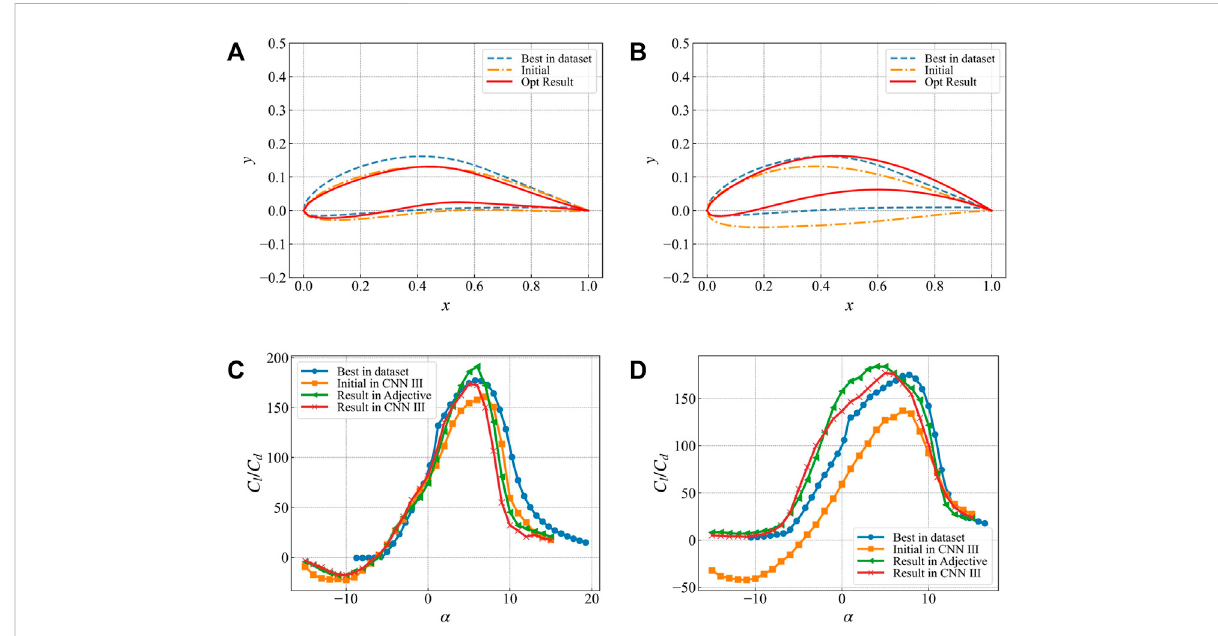
FIGURE 13 Comparisonofoptimizationresultswiththebestairfoilunderthecorrespondingtargetinthedataset (A) Airfoilgeometrywith6 ° singleangleof attack lift-to-drag ratio as the optimization target (B) The multi-angle of attack lift-drag ratio is the airfoil geometry under the target (C) The lift-drag ratiocurveunderthetargetwith6 ° singleangleofattack lift-dragratio (D) Thelift-dragratiocurveunderthetargetwithmultipleanglesofattack lift- drag ratio.